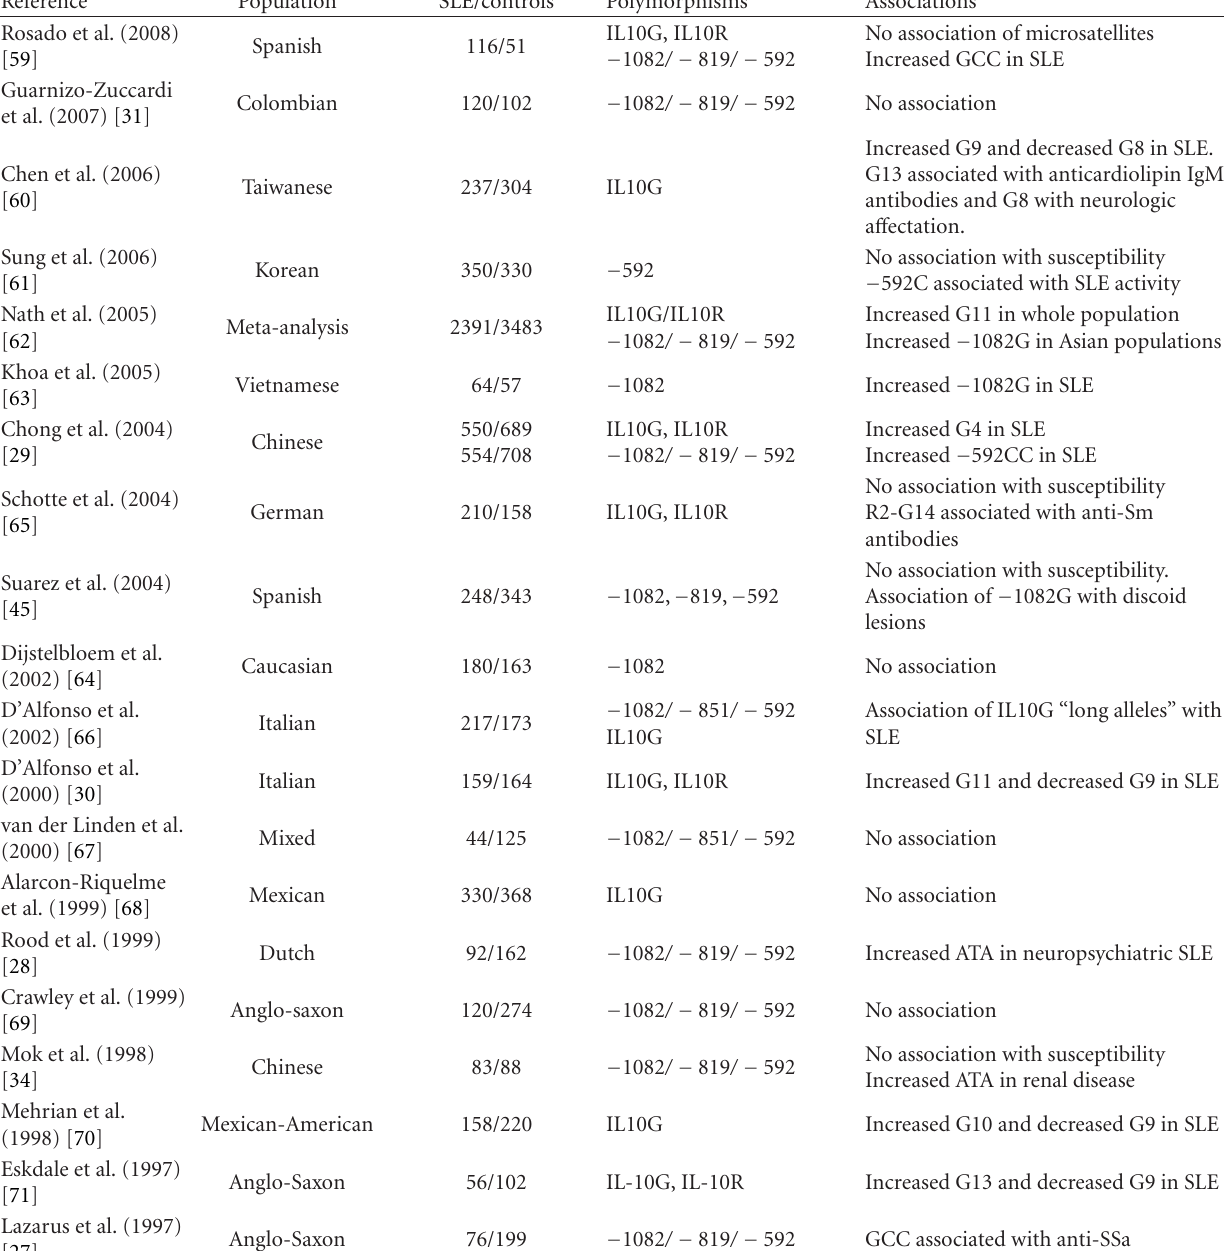
Table 2: Summary of association studies of IL-10 promoter polymorphisms with